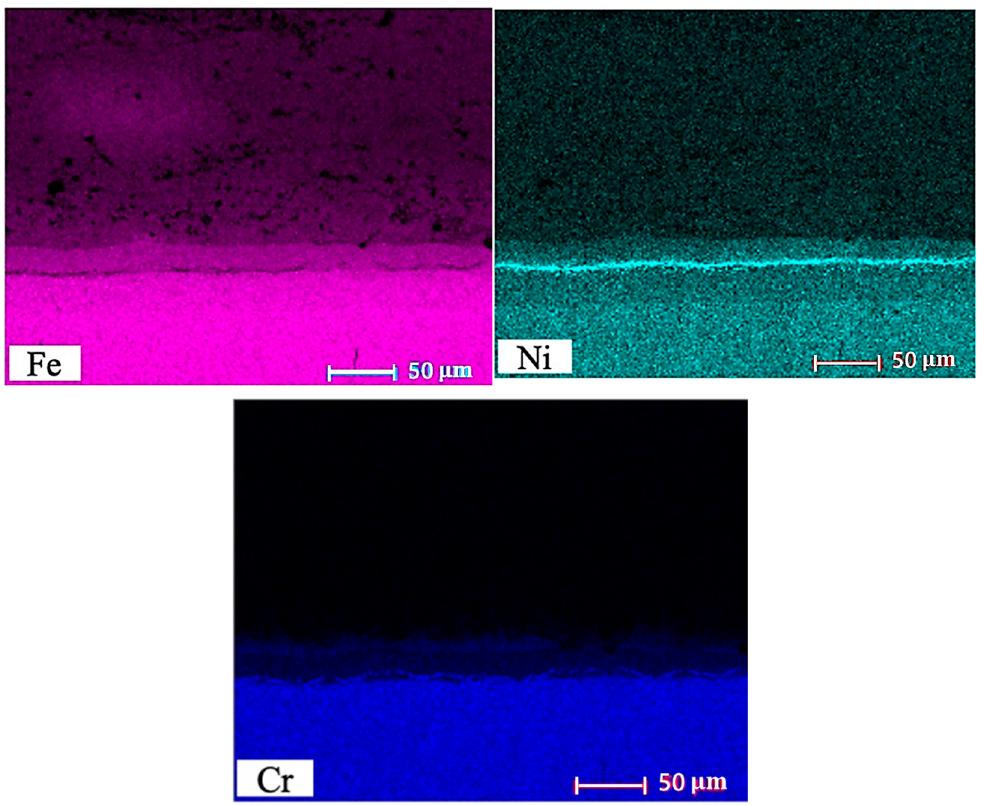
Figure 8. SEM image and the corresponding EDS elemental mapping of the cross-section of a sample processed at 850 °C and 20 MPa for 7200 s.